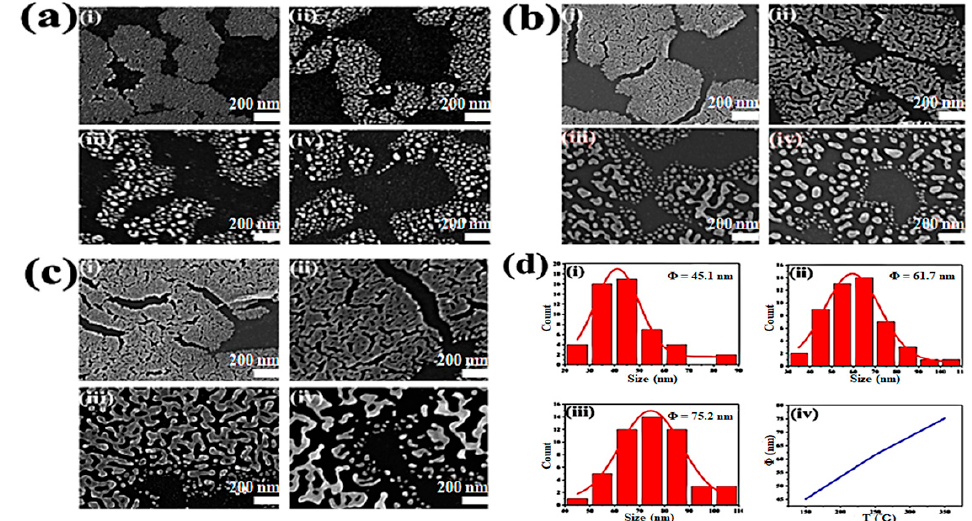
Figure 3. SEM images of Au films deposited on silicone oil surfaces with film thickness of ( a ) 5 nm, ( b ) 10 nm, and ( c ) 20 nm, in which ( i – iv ) represent Au films without annealing and annealed at 150 ◦ C, 250 ◦ C and 350 ◦ C for 1 h, respectively. ( d ) Diameter distribution of nanoparticles in 5 nm Au films at ( i ) 150 ◦ C, ( ii ) 250 ◦ C, and ( iii ) 350 ◦ C, and ( iv ) exhibits the relationship between annealing temperature and mean diameter of Au